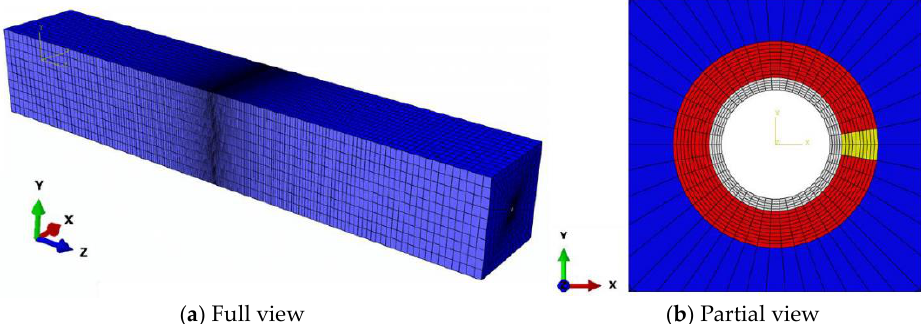
Figure 3. Circumferential crack propagation model of cement sheath body.